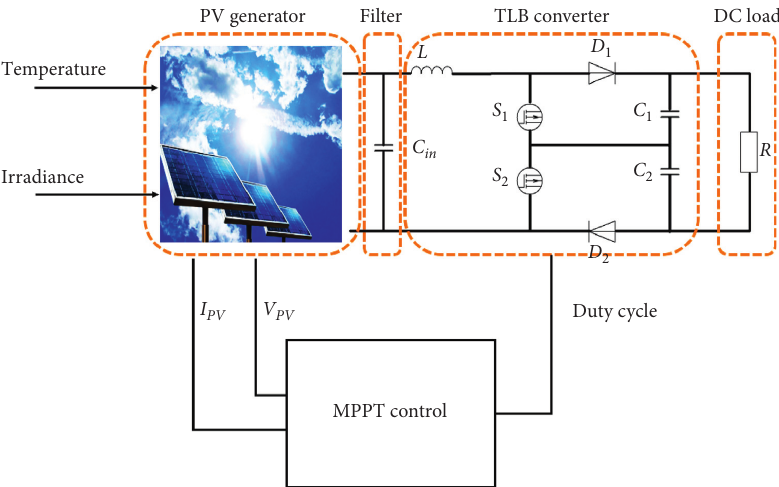
Figure 2: The dealed PV system scheme with MPPT control.